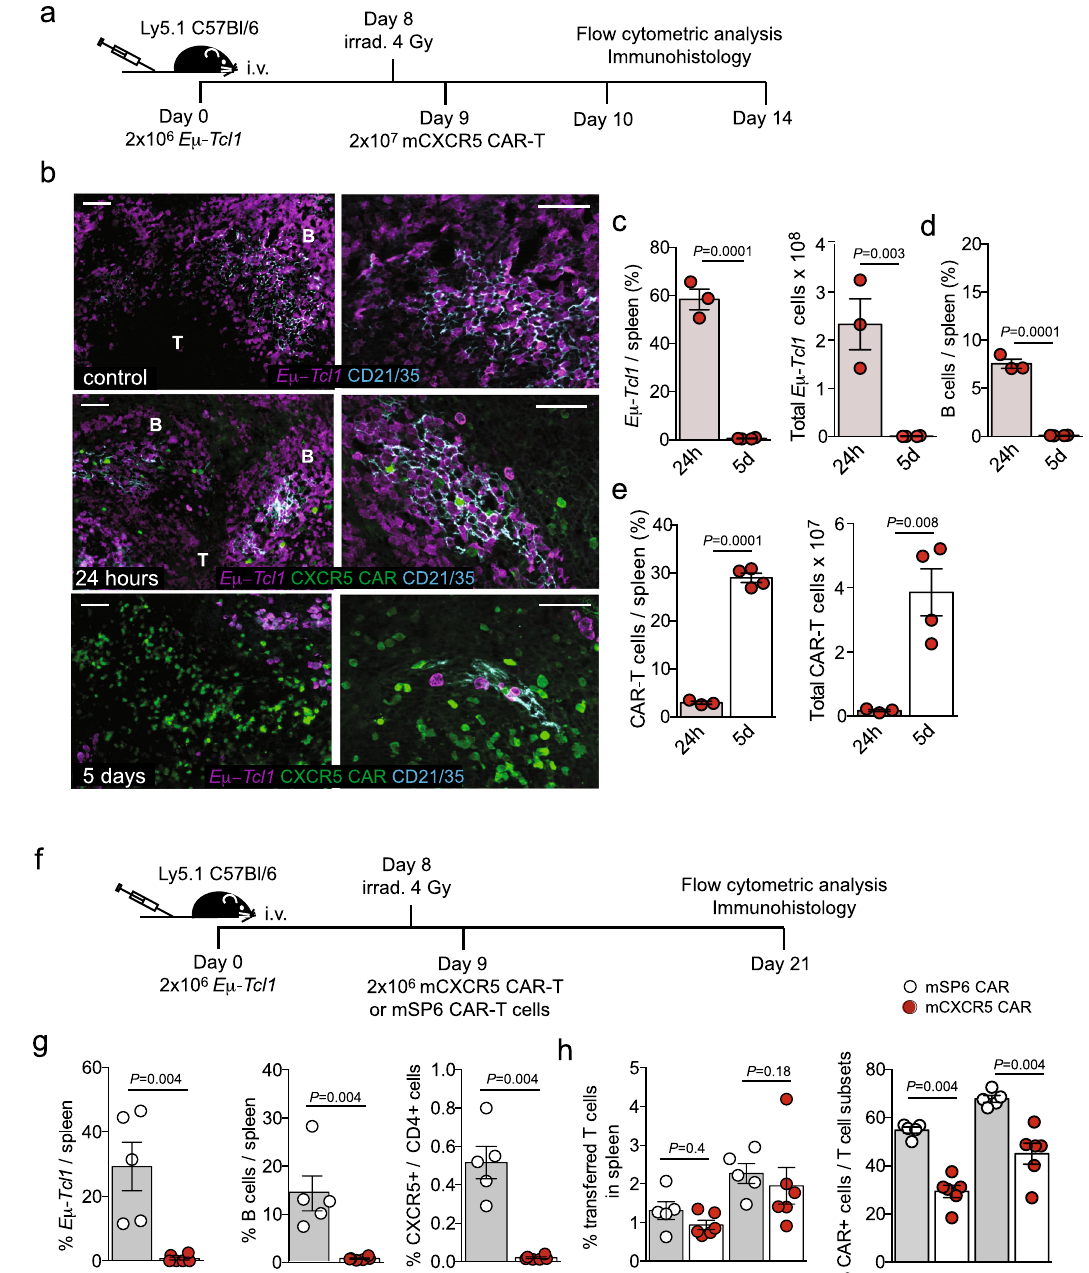
Fig. 9 Anti-murine CXCR5 CAR-T cells gain access to tumor cells in the B cell follicles and exert potent anti-lymphoma activity. a – e Congenic mice were injected with 2× 10 6 primary E μ -Tcl1 lymphoma cells 8 days later, the mice were irradiated (4Gy) followed by i.v. administration of 2× 10 7 CAR-T cells